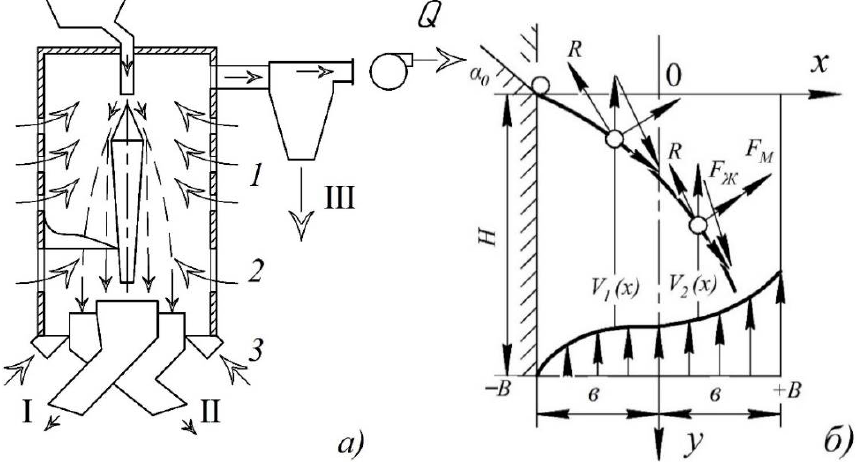
Figure 3. Distribution of air flow velocity and pressure in a vertical channel, which narrows at ( a )— (cid:1848) (cid:3017) = 5 m/s; ( b )— (cid:1848) (cid:3017) = 9 m/s.